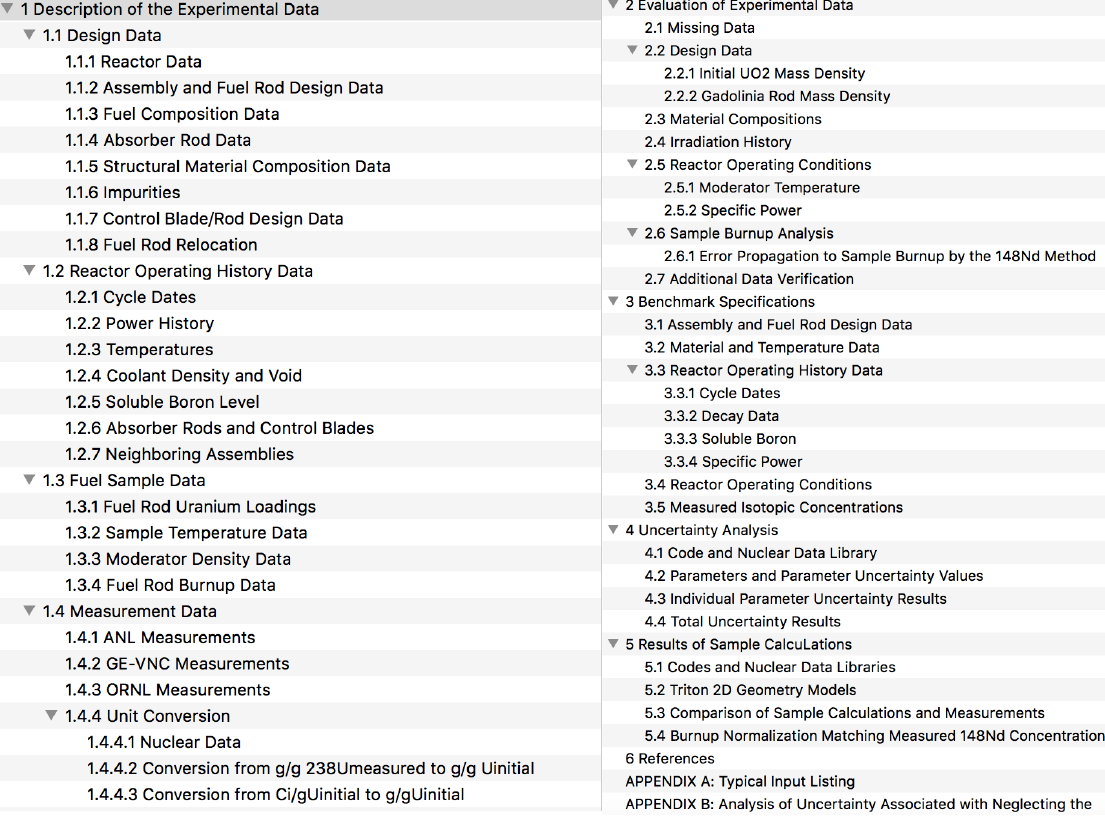
Figure 2. Evaluation report content example (for TMI-1 evaluation #10, specified in Table